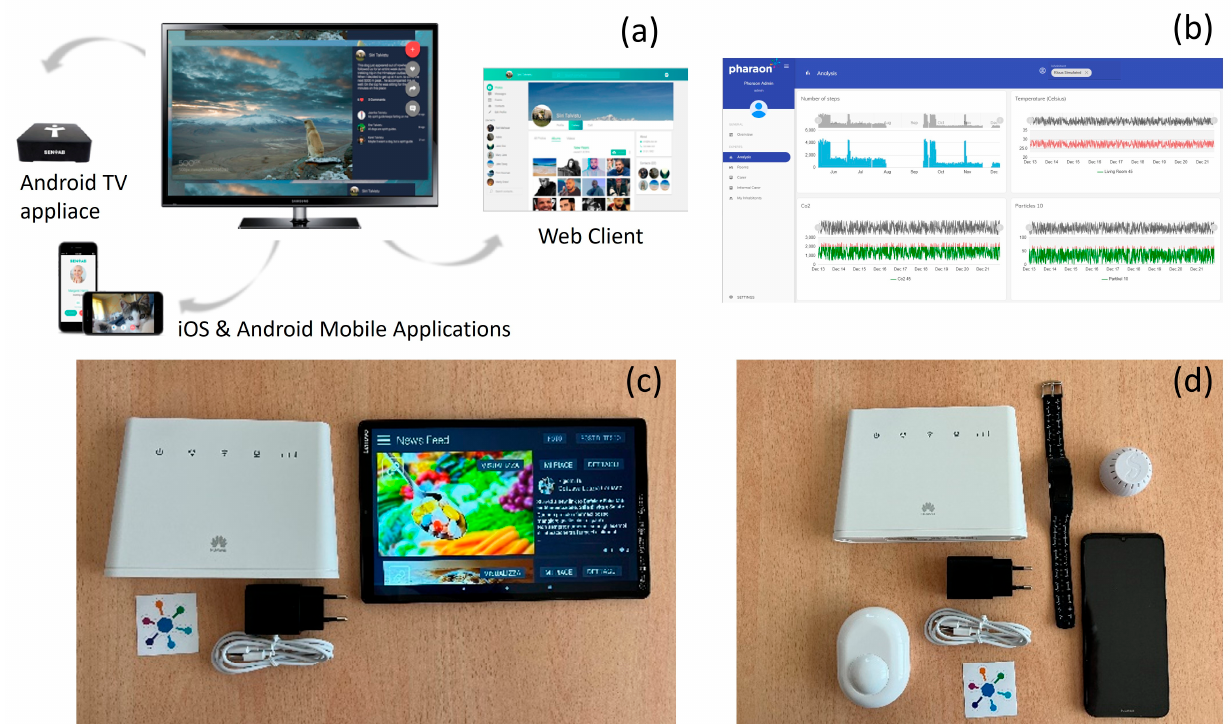
Figure 4. The technologies used were ( a ) the SENTAB system; ( b ) the Discovery Dashboard, an example of the data showed on the interface; ( c ) for the health management and monitoring scenario, the gateway or smartphone (if the older adult did not have one) were used to connect the smartwatch, the PIR movement, and humidity and temperature sensors; and ( d ) for the monitoring socialization and inclusion support, the gateway and the tablet were used with the SENTAB application installed on the tablet.